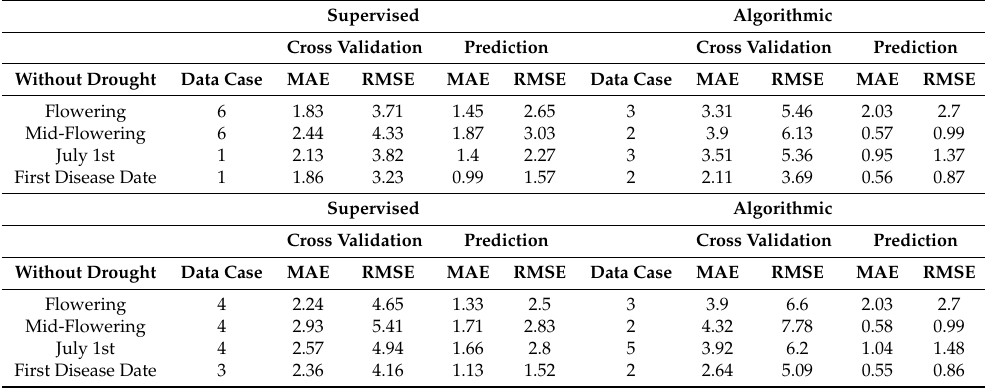
Table 3. Inter-comparison of model performance in parameter learning from both supervised and algorithmic learning in a total of 32 subsets of network random variables in four different